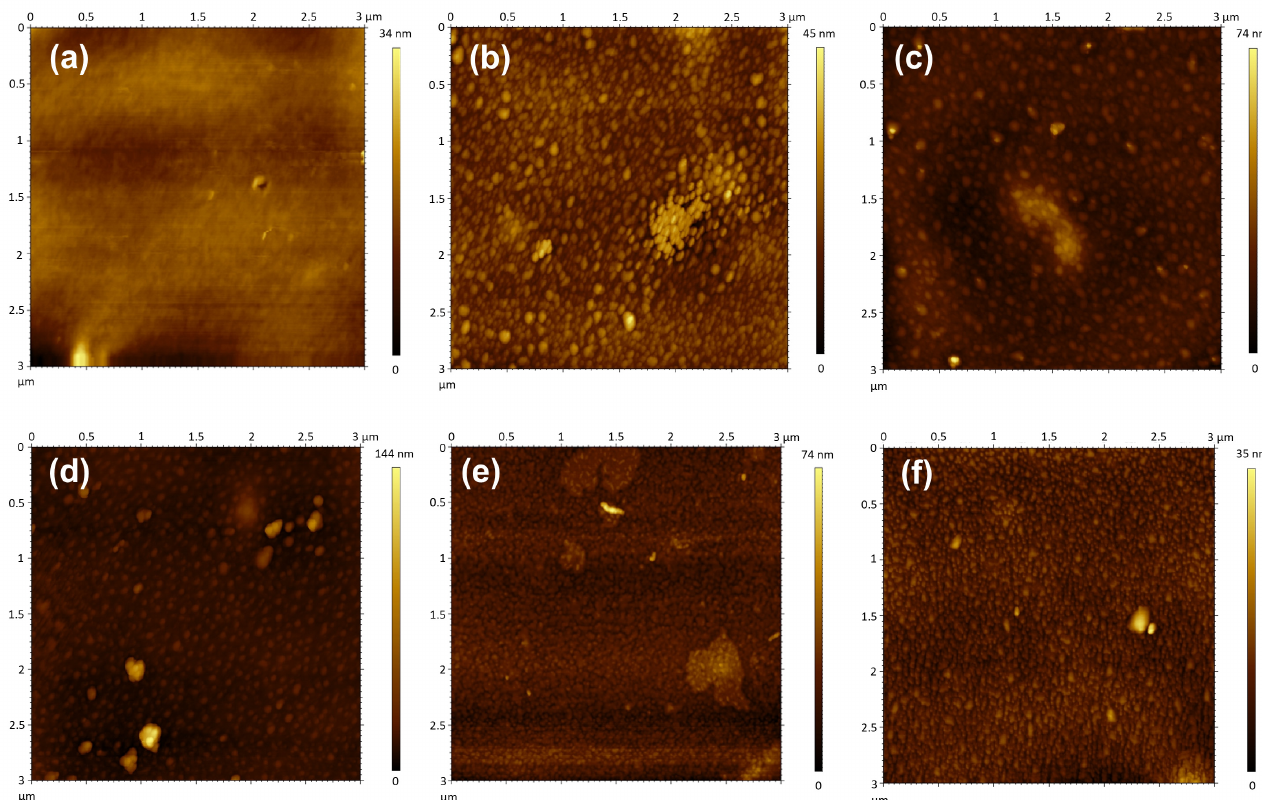
Figure 4 . Surface topography images from AFM: ( a ) the untreated PET sample, and the plasma- treated samples with ( b ) 7.5 kW power and 4 m/min speed, ( c ) 15 kW power and 4 m/min speed, ( d ) 7.5 kW power 12 m/min speed, ( e ) 15 kW power and 12 m/min speed and ( f ) 11.25 kW power and 8 m/min speed.